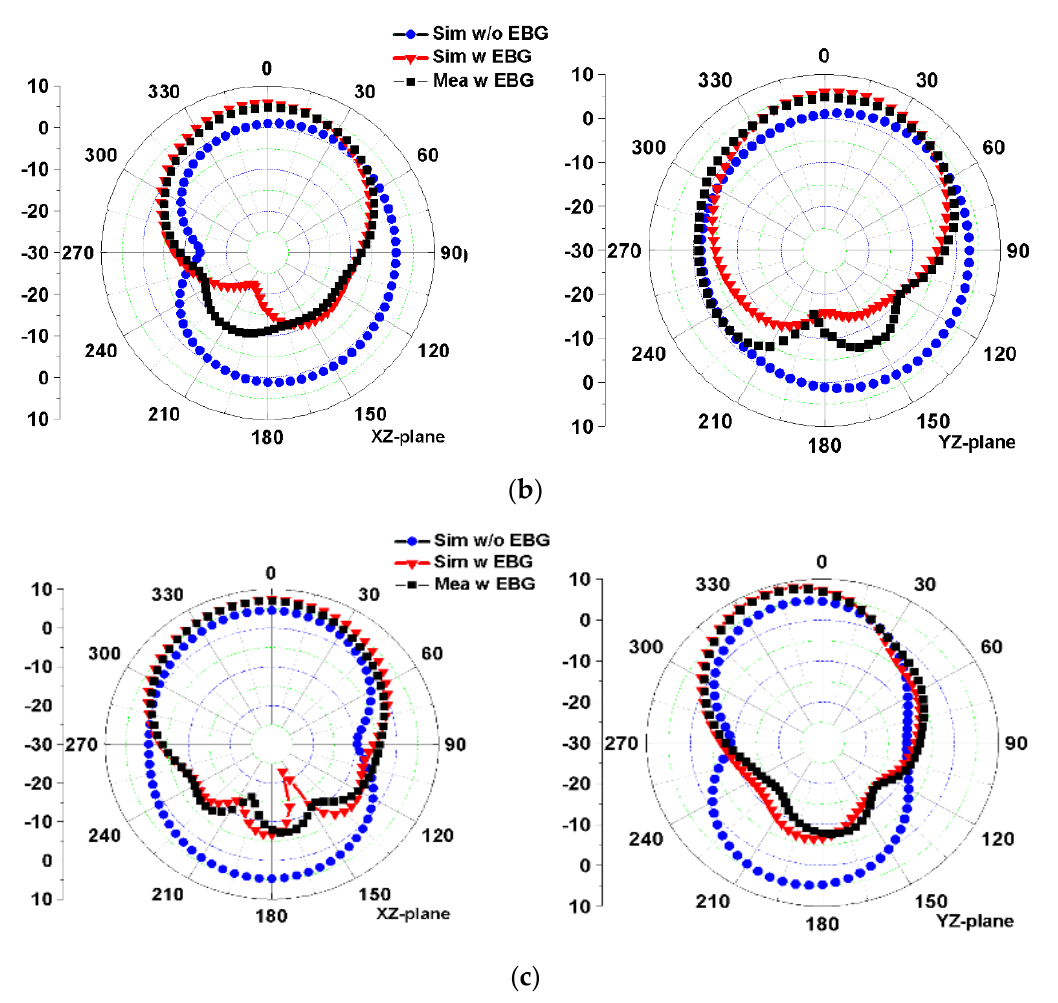
Figure 11. Simulated and measured radiation patterns of the integrated antenna in the xz plane and yz plane at: ( a ) 2.45 GHz, ( b ) 3.5 GHz, and ( c ) 5.8 GHz.